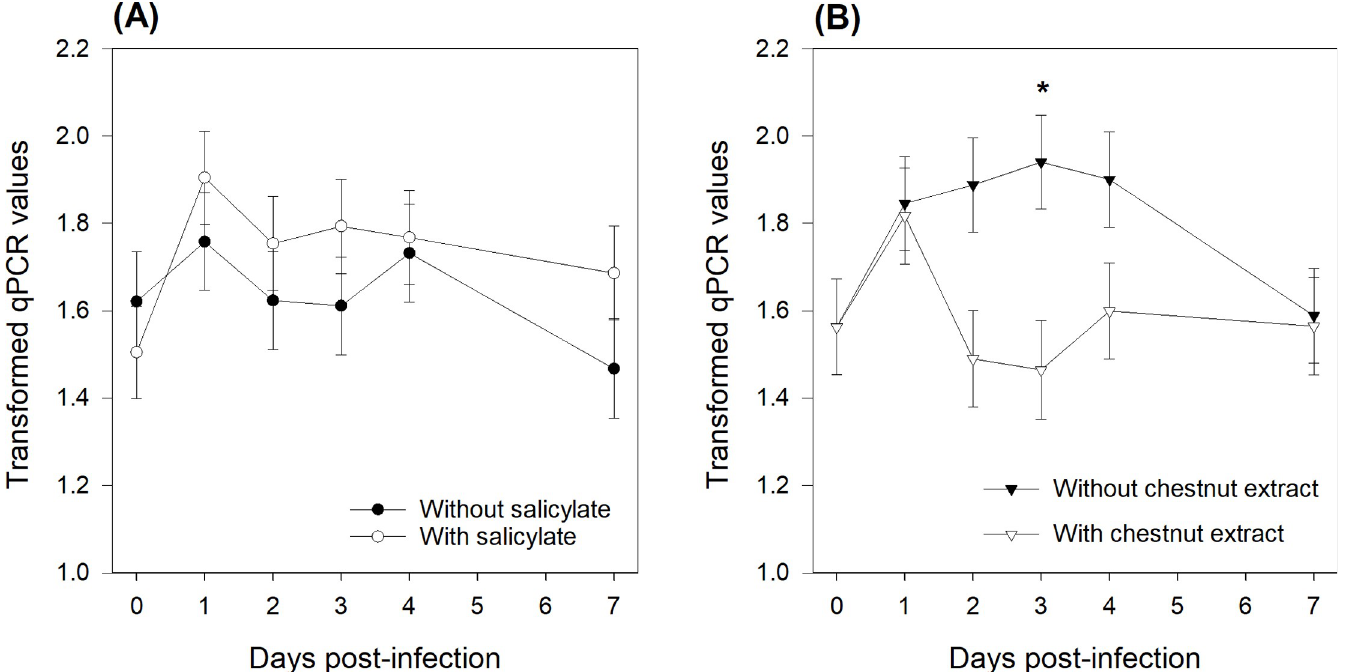
Fig 4. Effect of sodium salicylate supply (A) and chestnut extract supplementation (B) on heat-labile toxin (LT) gene abundance as determined using qPCR in feces samples collected from all piglets at days 0, 1, 2, 3, 4, and 7 post-infection. Data are presented as transformed qPCR values according to: Y ¼ 3 (cid:0) 1 represents the ng heat-labile < toxin-DNA per g of feces dry matter. From days 0–4, pigs (N = 36) in the SA+ group were offered a daily dose of sodium salicylate (35 mg/kg BW per day, sodium salicylate, ReagentPlus 1 , S3007, Sigma-Aldrich Chemie GmbH; Buchs, Switzerland). From days 0–4, pigs (N = 36) in the SA- group were offered a daily dose of tap water. Pigs (N = 36) in the CE- group had ad libitum access to a control standard starter diet, which was formulated according to the Swiss feeding recommendations for pigs (Agroscope, 2017). Pigs (N = 36) in the CE+ group had ad libitum access to the chestnut extract (CE)-supplemented diet, in